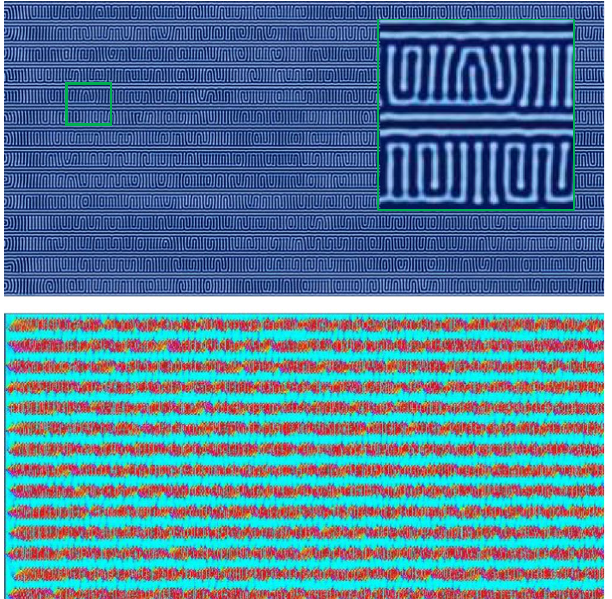
lamellae bounded by parallel lamellae.